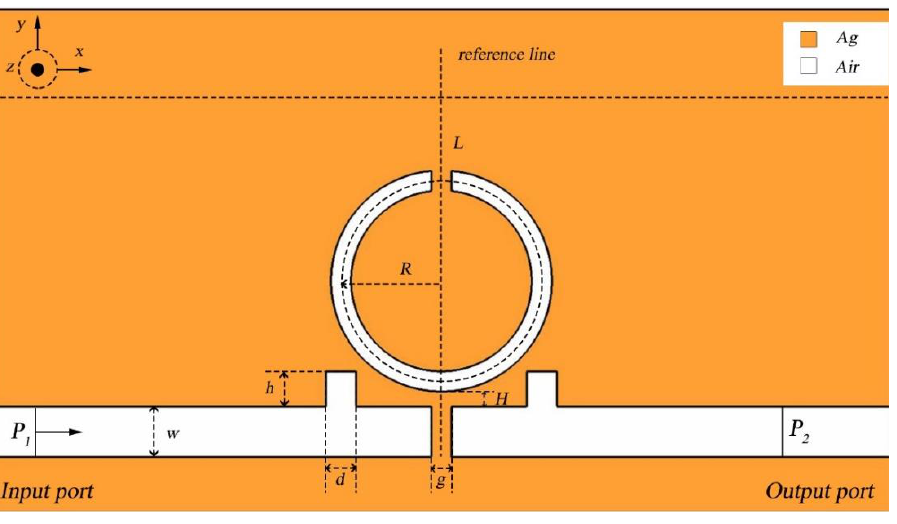
Figure 1. Schematic diagram of the MIM waveguide structure consisting of a DSRSW and a CSRRC.